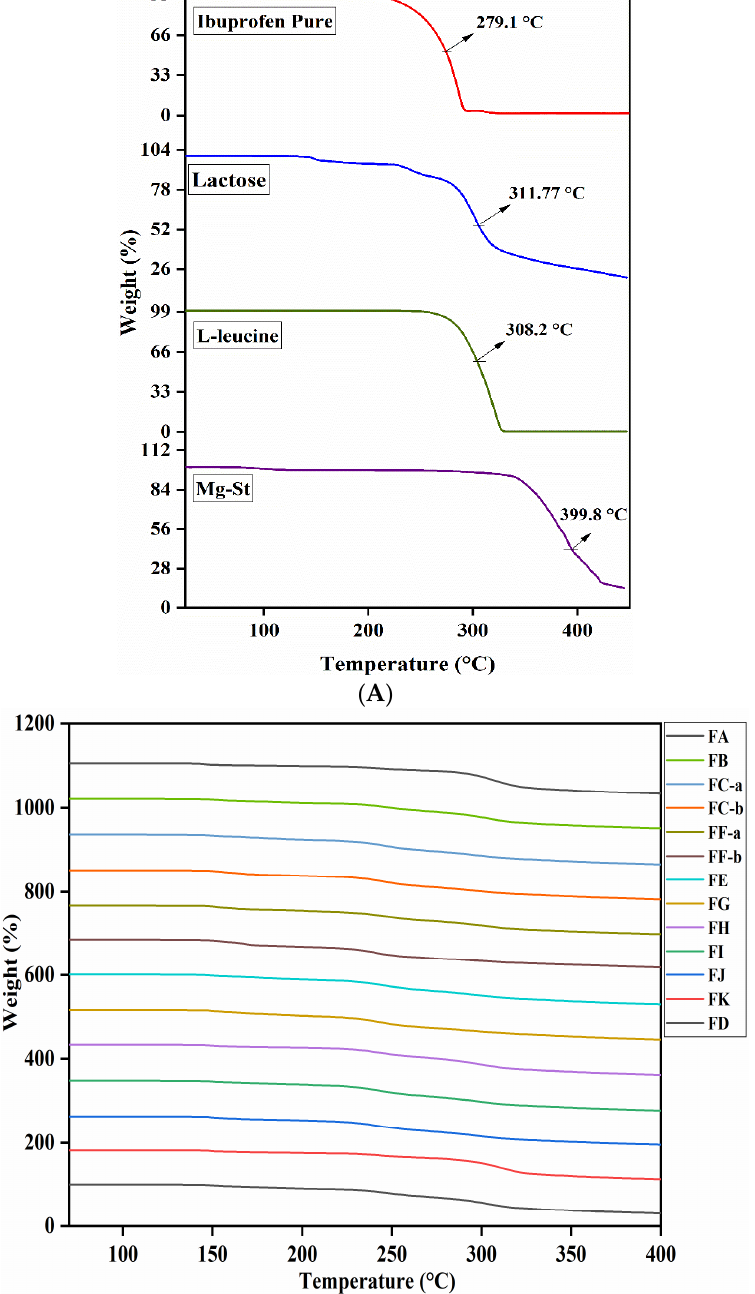
Figure 6. Stacked TGA thermograms of ( A ) raw materials, ( B ) developed DPI formulations (n = 3, Mean ± SD).